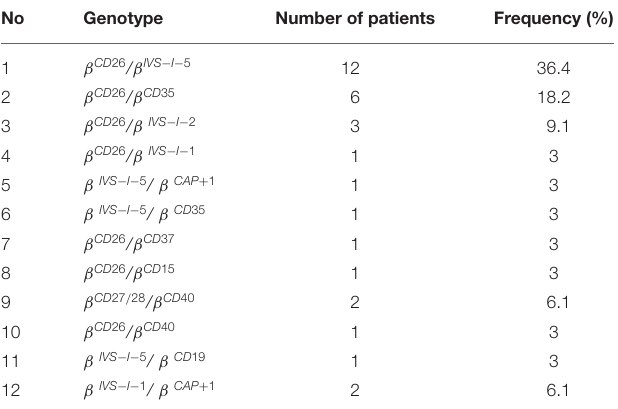
TABLE 3 | The frequency of β -thalassemia genotype